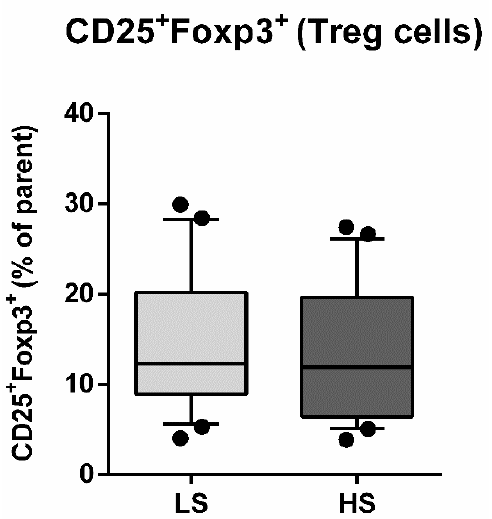
Figure 3. Effects of a 7 ‐ day high ‐ salt diet on the frequency of peripheral regulatory T cells (Treg) in healthy young individuals. Relative frequencies of peripheral Treg are presented as box ‐ and ‐ whisker plots 10 to 90 percentiles; Paired t ‐ test, LS vs. HS; p < 0.05 was considered significant.